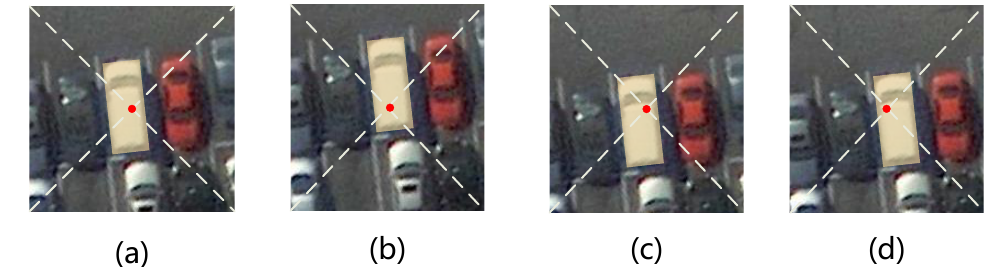
Figure 9. Figure ( a ) shows the standard saliency region. In order to increase the robustness of saliency region detection, we translated the saliency region, as shown in ( b – d ), in the training phase, and the translation range ensures that the center of the center window is within the saliency